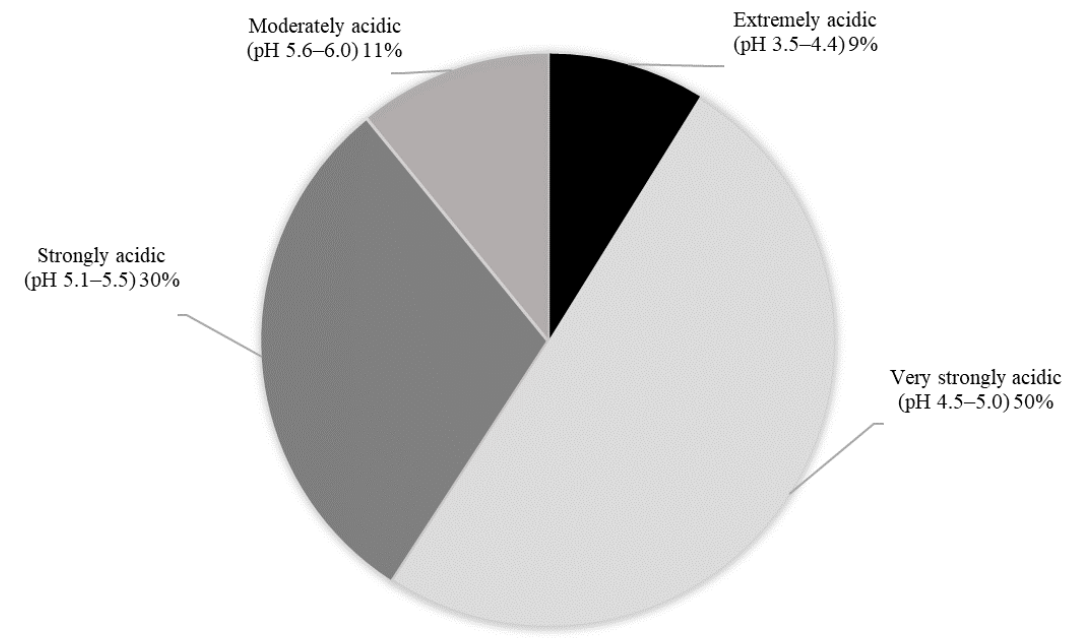
Figure 2. Proportion of soil pH ranges in sampled potato fields ( n = 147).